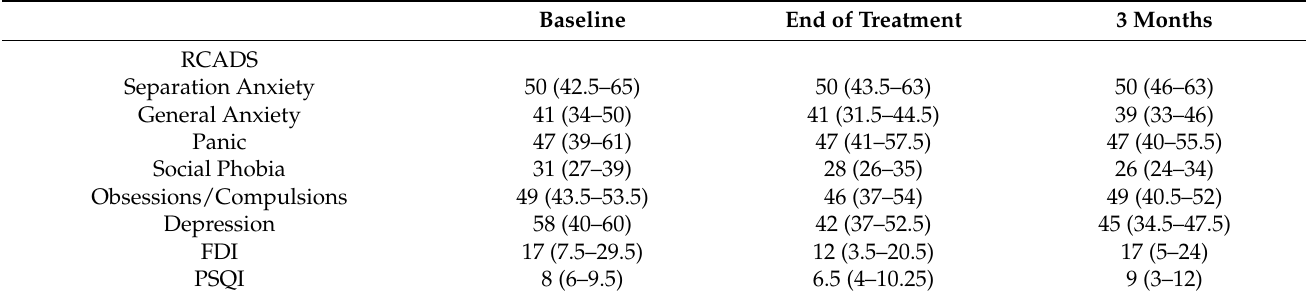
Table 3. Median and range RCADS, FDI, and PSQI at baseline, after treatment, and 3 months after treatment. Baseline End of Treatment 3